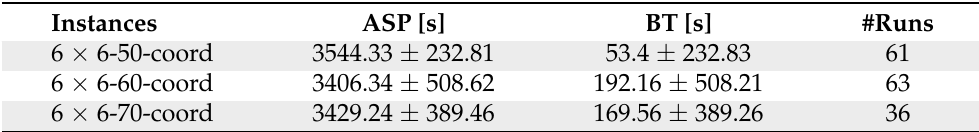
Table 4. Runtime distribution and number of timeout runs within the coordinated approach with timeout reached in the answer set solver.